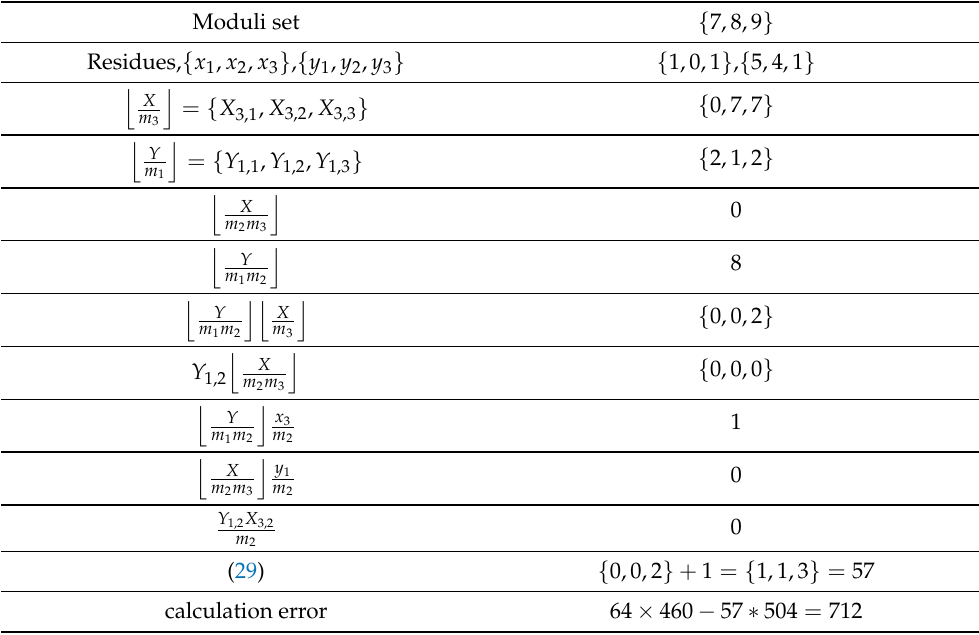
Table 2. Computation traces of X × Y = 64 ∗ 460 of the proposed high precision RNS multiplier. Moduli set { 7,8,9 } Residues, { x 1 , x 2 , x 3 } , { y 1 , y 2 , y 3 } { 1,0,1 } , { 5,4,1